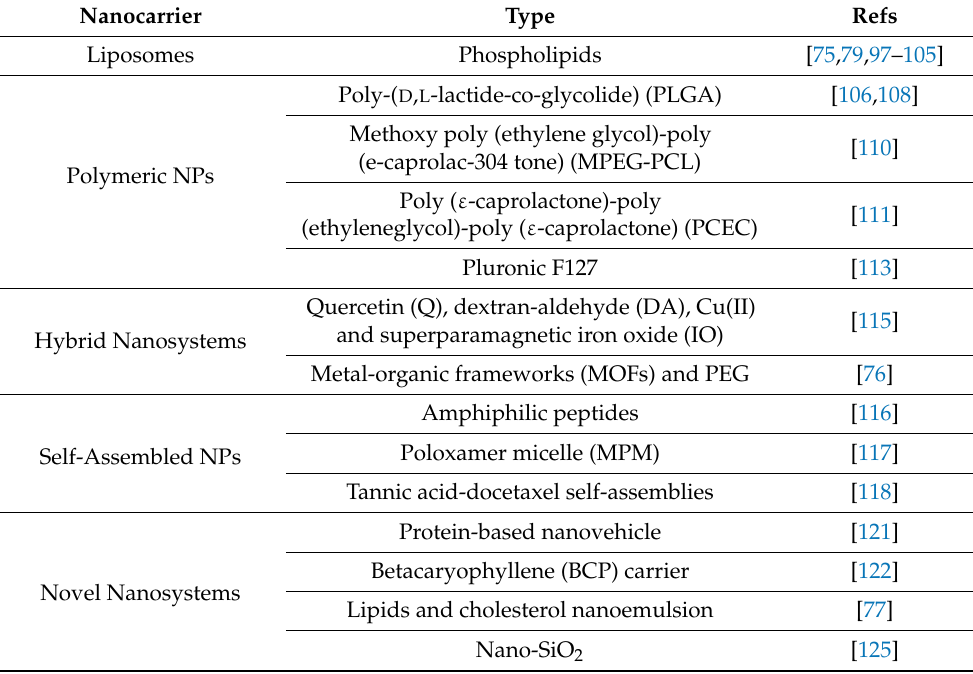
Table 1. Categorization of NP-based delivery of PARP inhibitors for the treatment of different cancer